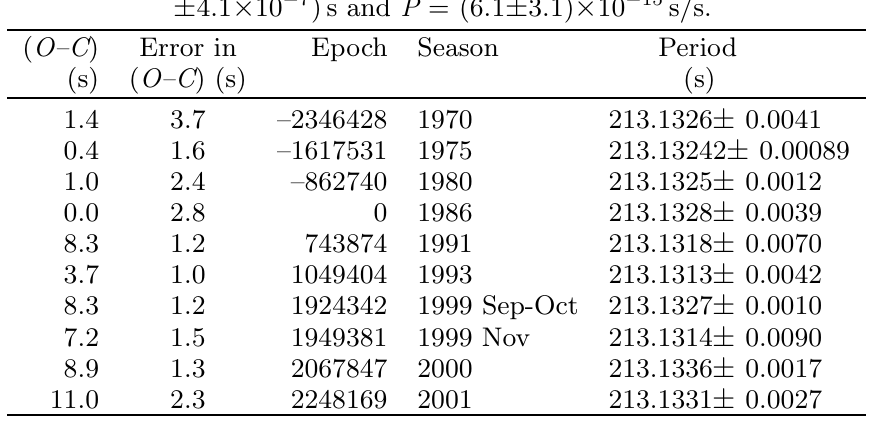
Table 2. ( O-C ) Table for period P = (213.13260456 ±